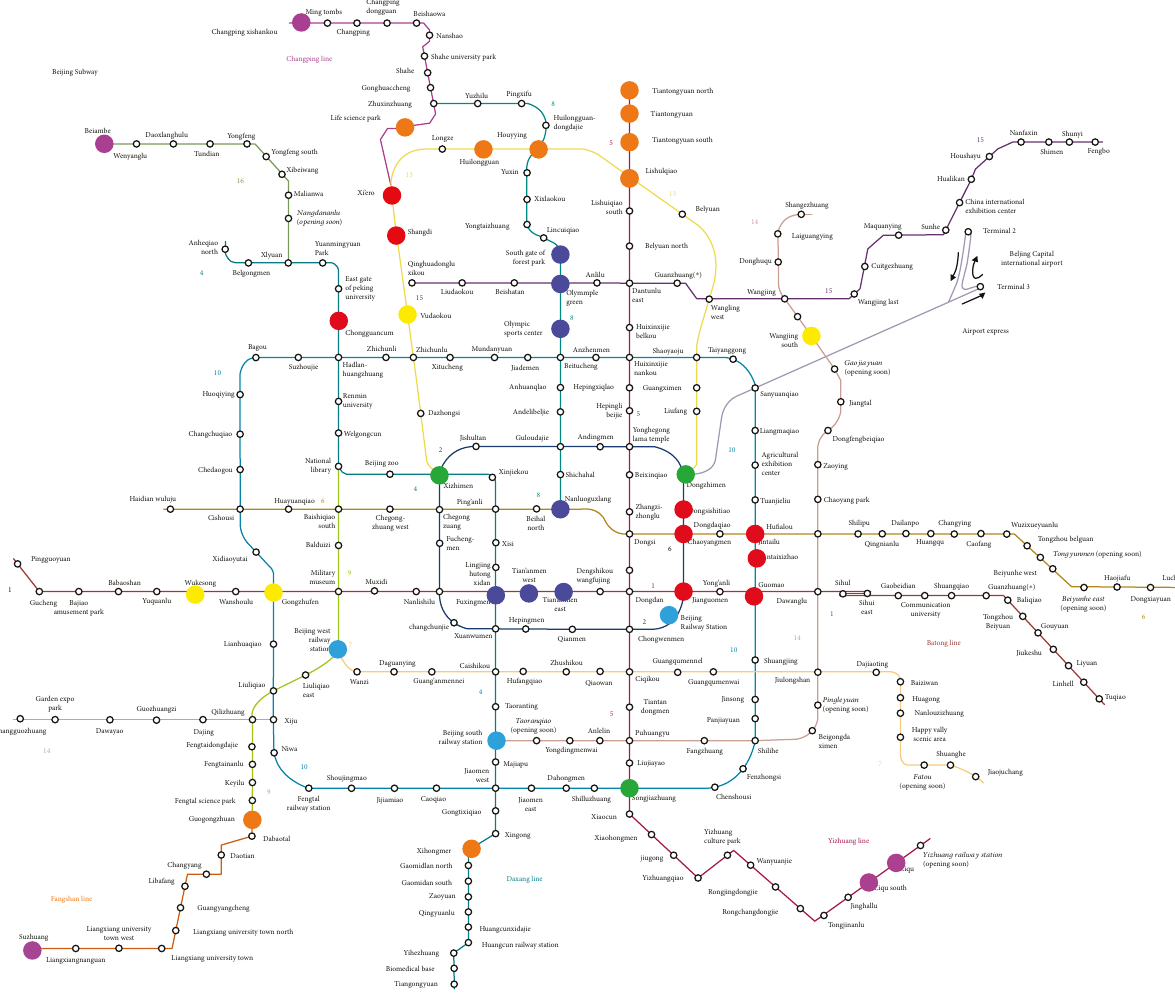
Figure 2: The typical stations for each category in Beijing